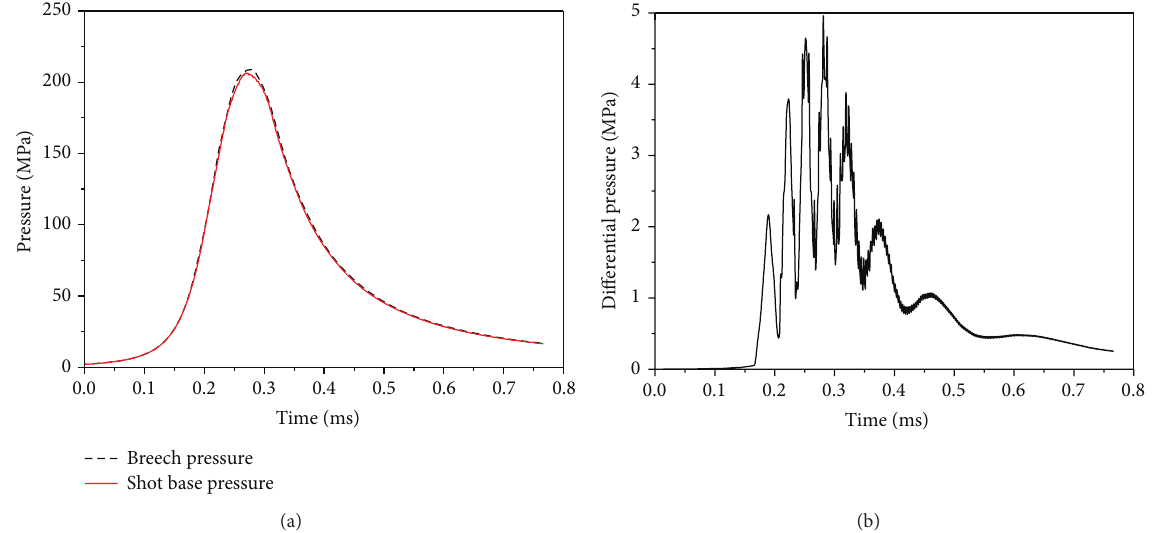
Figure 4: (a) Time history of breech and base pressures for 𝑚 𝑝 = 0.245 g, without barrel friction. (b) Differential pressure-time history for = 0.245 g, without barrel 𝑚 𝑝